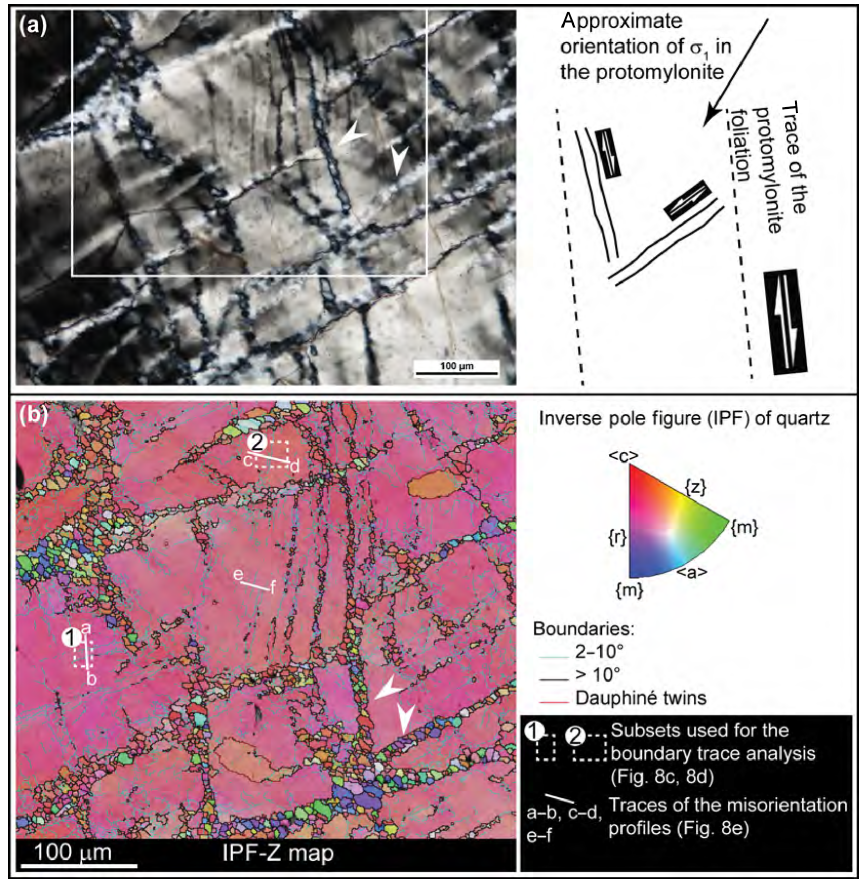
Figure 8. EBSD analysis of quartz in the host protomylonite. (a) Microstructure of the analysed site. The white arrows in (a) and (b) indicate the same pair of conjugate shear. (b) Inverse pole figure map with the respect to the protomylonitic foliation in the host rock (vertical in the figure). Location of subset 1 and 2 and trace of misorientation profiles (a) – (b) , (c) – (d) , and (e) – (f) are